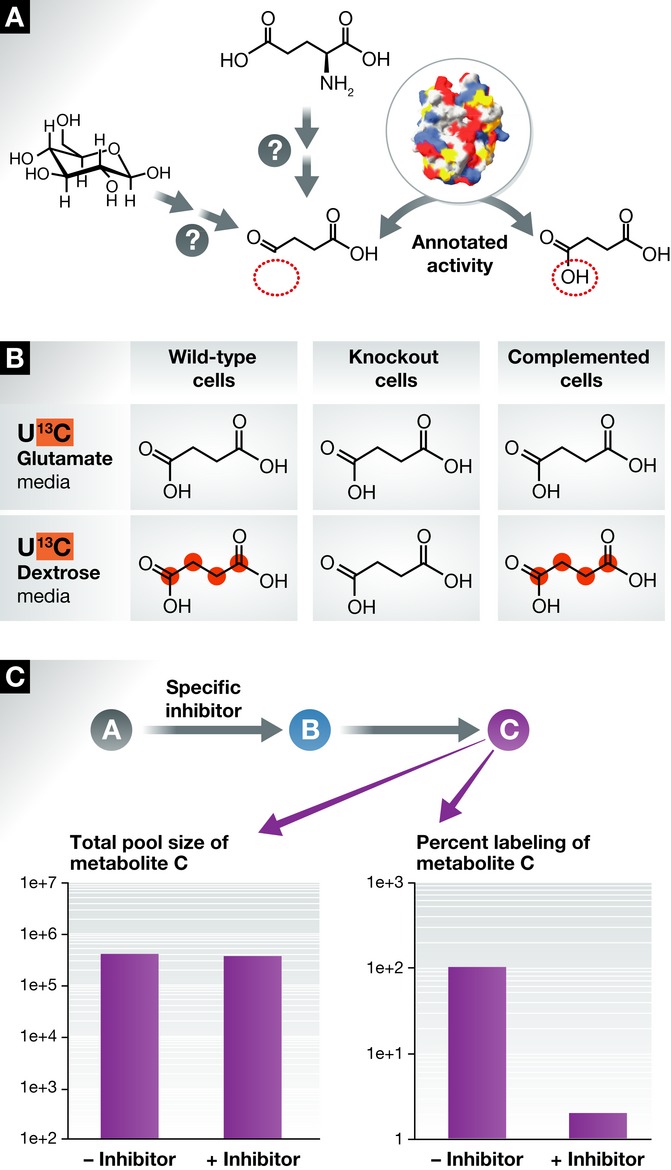
Labelling experiments can probe pathway(s) and the metabolic context of newly identified
enzymatic activities(A) An enzymatic reaction is identified by activity-based metabolic profiling or another method.
The structure is of Mycobacterium tuberculosis CitE 99. (B) Possible outcome of a labelling experiment designed to probe the origin of the
carbon backbone of succinate. In this case, as glutamate labelling does not generate labelled
succinate, a classic GABA shunt starting from glutamate is ruled out. Labelling with dextrose would
therefore indicate a mitochondrial role for this newly identified enzyme. (C) Labelling experiment
designed to confirm that the enzymatic activity identified belongs to the pathway described. The
specific inhibition of synthesis of compound B leads to no change in the pool size of metabolite C.
However, it drastically diminishes its labelling, supporting the relationship between A and C.